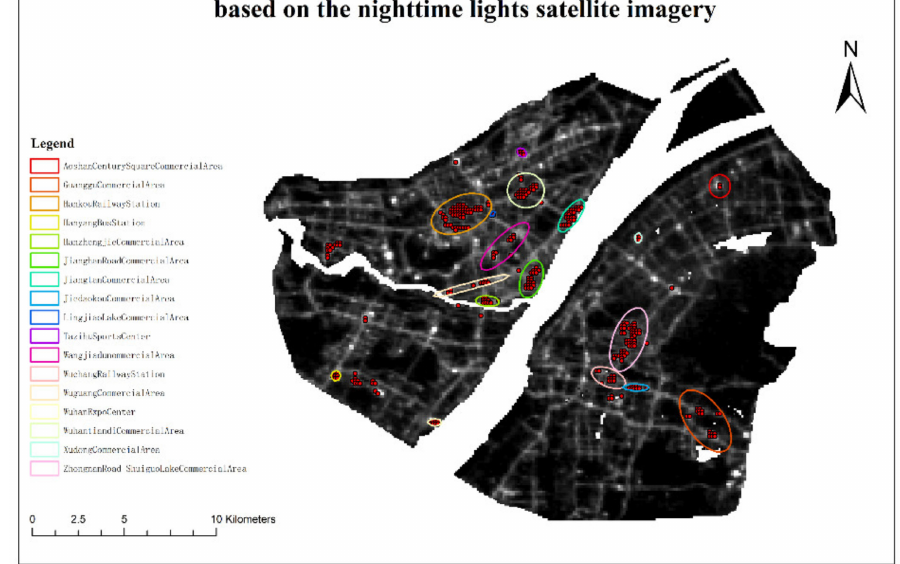
Figure 6. Geographic distribution metrics result of Wuhan city’s commercial area based on the nighttime lights satellite